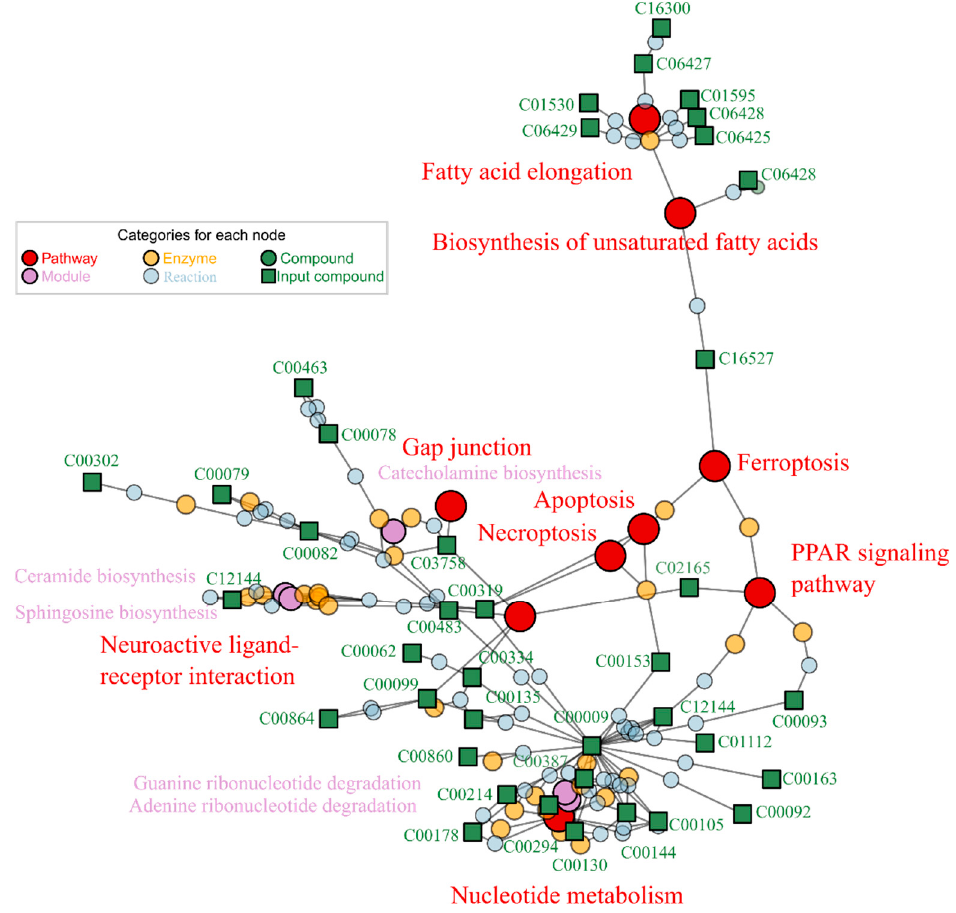
Figure 4. Metabolome response to alcohol exposure (G2) in